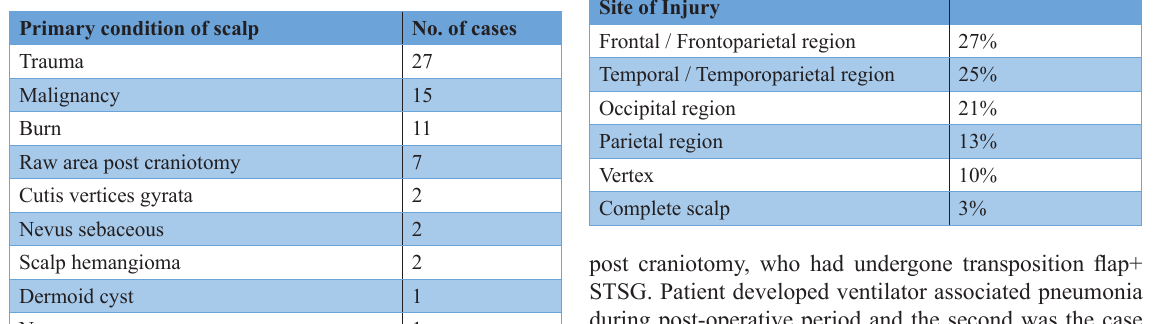
Table 3. Distribution of site of reconstruction Table 1. Primary condition of the scalp requiring